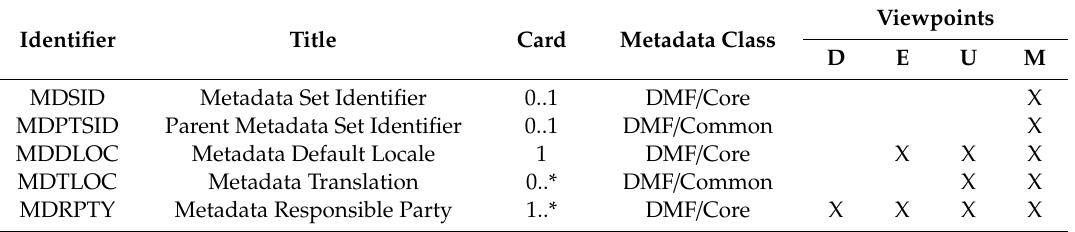
Table 10. Example of Defence Geospatial Information Working Group metadata foundation (DMF) classification